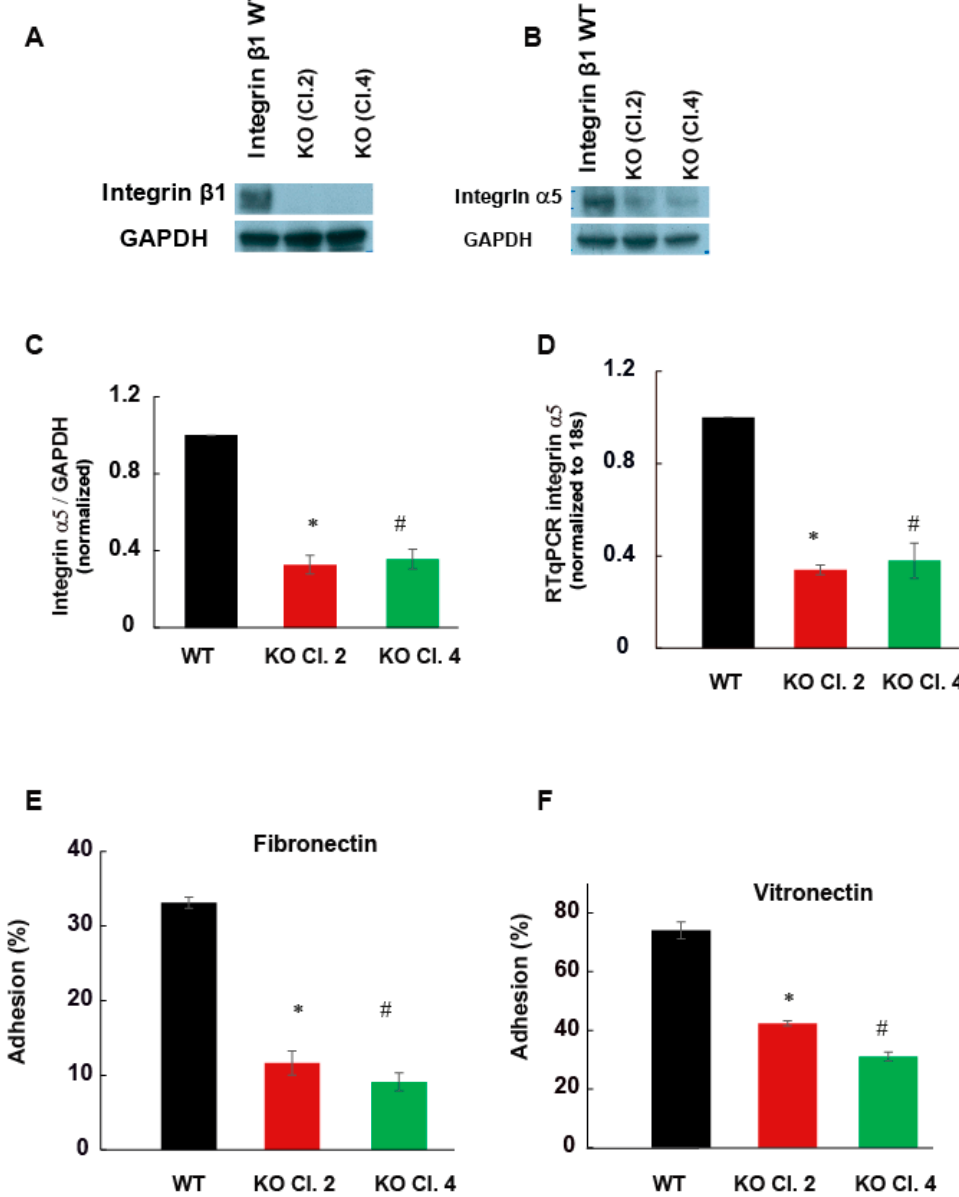
Figure 3. Integrin β 1 deletion decreased the cellular adhesion of MIA PaCa-2 cells to vitronectin and fibronectin. ( A ) Integrin β 1 expressing MIA PaCa-2 and integrin β 1 KO clones were immunoblotted by anti-integrin β 1 antibody. GAPDH was used as the loading control. ( B ) Cell lysate was immunoblotted with integrin α 5 antibodies. GAPDH was used as the loading control. (C) Quantification of integrin α 5 expression normalized to GAPDH, mean ± SEM from three independent experiments ( n = 3). One-way ANOVA performed with Bonferroni’s test indicated a statistically significant decrease in